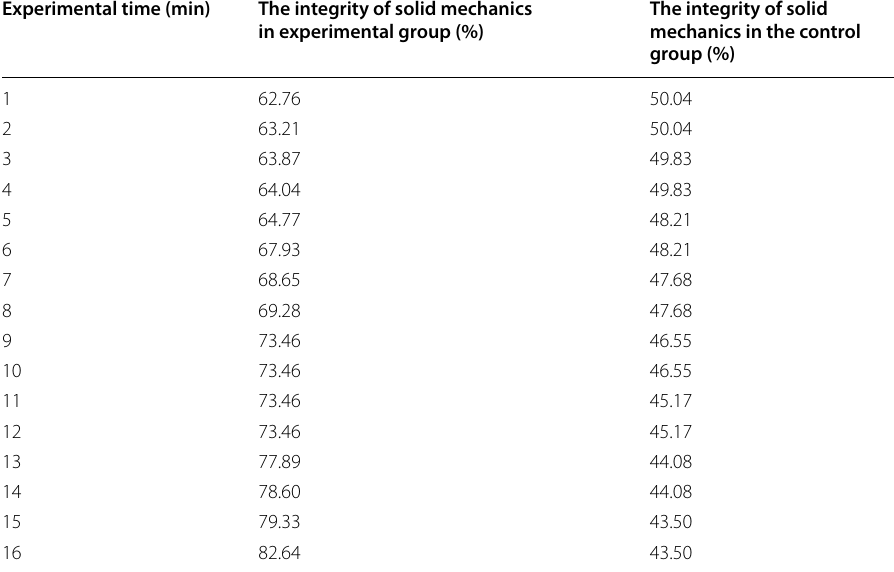
Table 5 Comparison of integrity of solid mechanics computing (operation status of middle mechanical